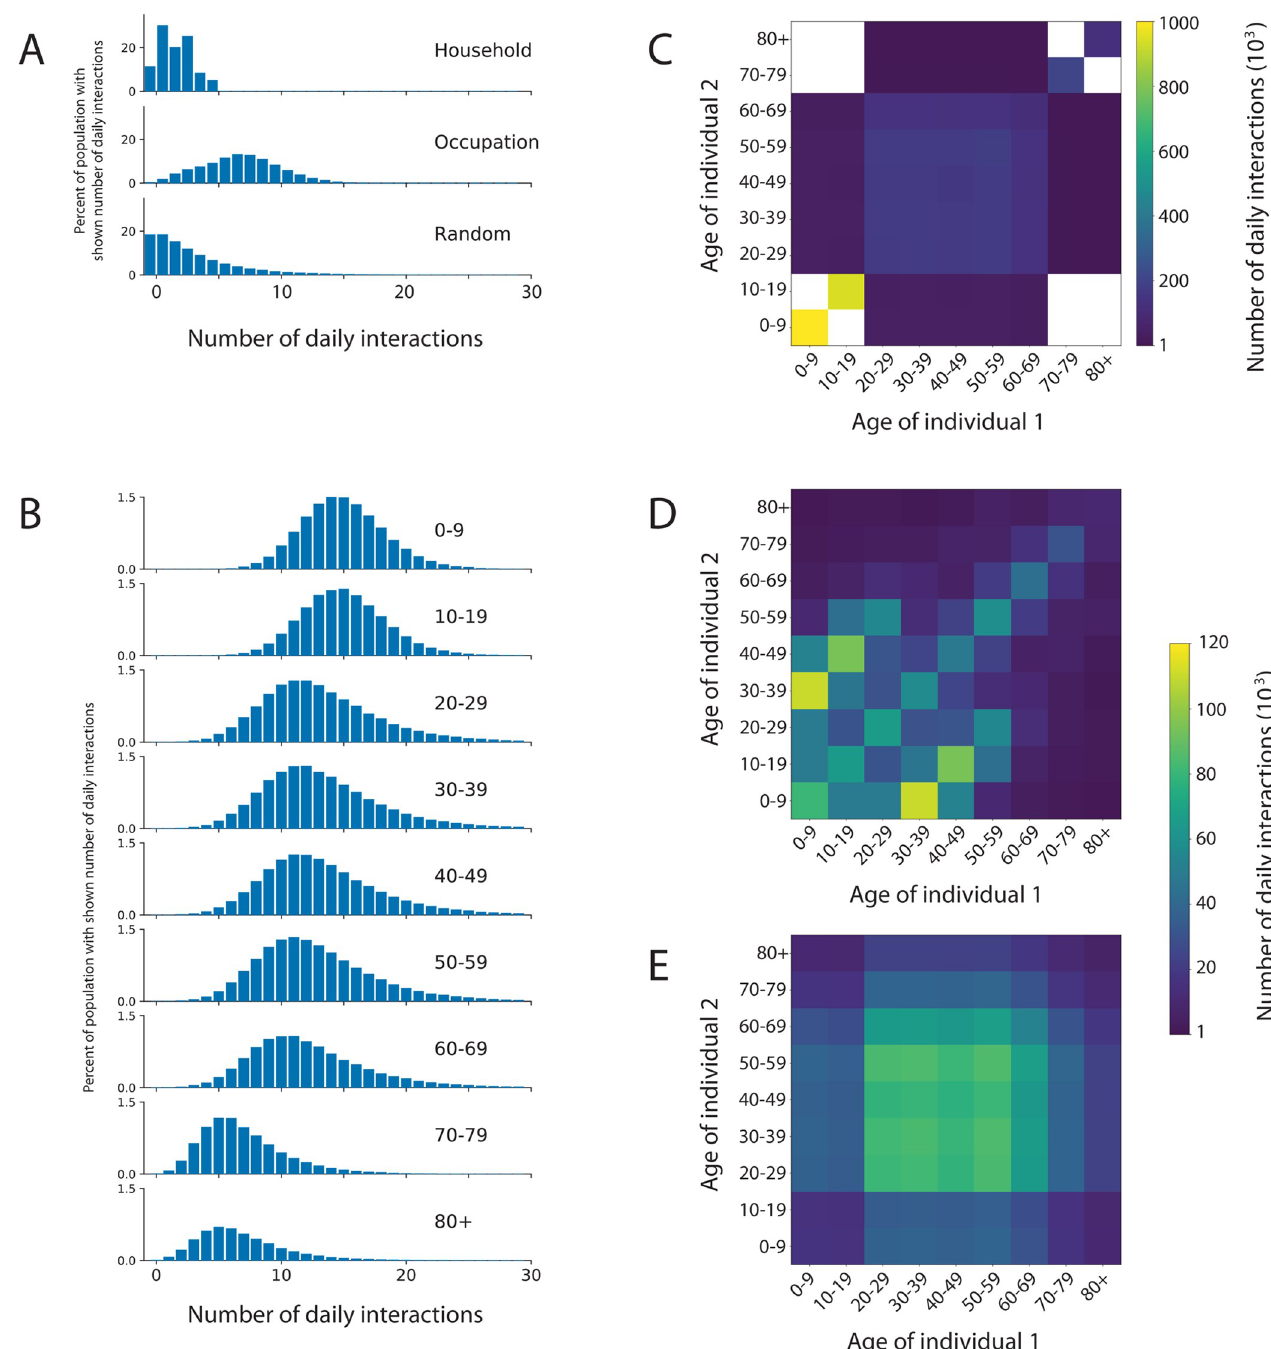
Fig 2. Summary of interactions between individuals within OpenABM-Covid19. (A) Distribution of daily simulated interactions stratified by the network upon which they occur. (B) Distribution of daily simulated interactions stratified by age group. Distribution of daily simulated interactions stratified by age group of both individuals in the (C) occupation, (D) household, and (E) random networks. Summarised interactions are from the first day of a single simulation in a population of 1 million individuals with UK-like demographics and household structure. Zero counts are shown in white in panels C, D, E.